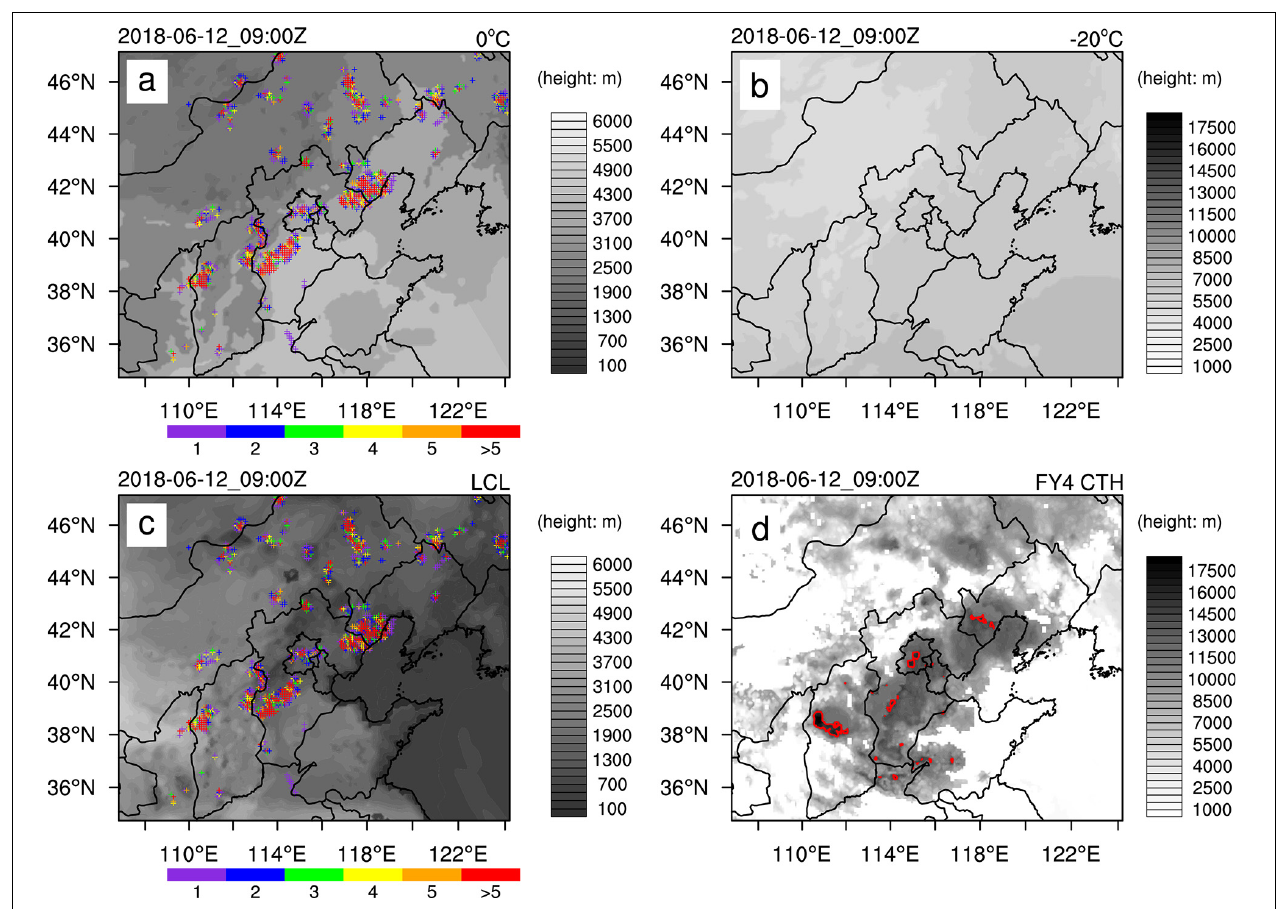
FIGURE 7 | The heights of 0 ◦ C (a) and − 20 ◦ C (b) in the background field, LCL (c) and FY4 CTH (d) (gray-shaded) for case 2 at 0900 UTC on 12 June